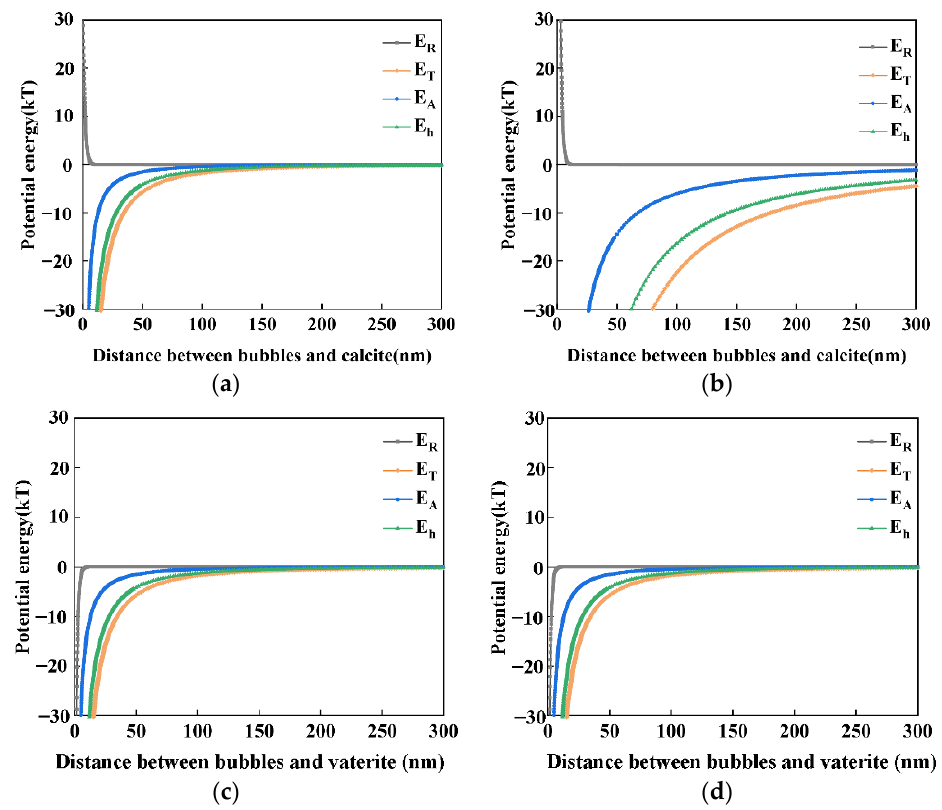
Figure 13. Total potential energy E T between the different sizes of air bubbles and calcium carbonate particles as a function of the distance between a nanobubble and a calcium carbonate particle by the extended DLVO theory (K = 10 − 19 J). Na + concentration was 0.05 M and Ca 2+ concentration was 2 × 10 − 5 M. ( a ) Air nanobubbles (120 nm, − 15 mV) and calcite particles (5 μ m, − 10 mV); ( b ) Air nanobubbles (700 nm, − 15 mV) and calcite particle (5 μ m, − 10 mV); ( c ) Air nanobubbles (120 nm, − 15 mV) and vaterite particles (6 μ m, 20 mV); ( d ) Air nanobubbles (700 nm, − 15 mV) and vaterite particles (6 μ m, 20 mV).